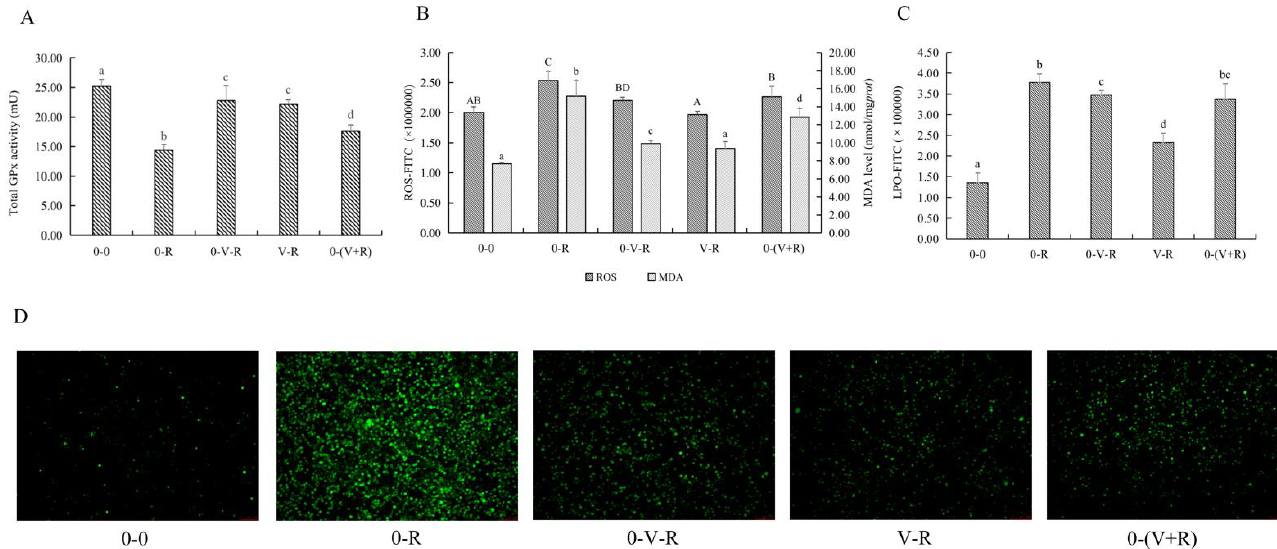
Figure 3. Effects of different incubation patterns of 1,25(OH) 2 D 3 on total GPx activity ( A ), ROS and MDA level ( B ), and LPO level ( C ) of ZFL after being treated with 3 µ M RSL3 for 6 h ( n = 6). Distribution of ROS (green fluorescence) in ZFL in each incubation pattern ( D ). Distribution images of ROS were taken using an inverted fluorescent microscope (Leica DMi8, Germany) in the FITC green fluorescent channel with a magnification of 10 × . Error bars represent the standard error of each group, and means with different superscript letters are significantly different ( p < 0.05),while the same letter means no statistical difference between two groups. In figure B, uppercase letters (A, B, C, D) and lowercase letters (a, b, c, d) indicate the statistical difference of ROS level and MDA level in each group, respectively .